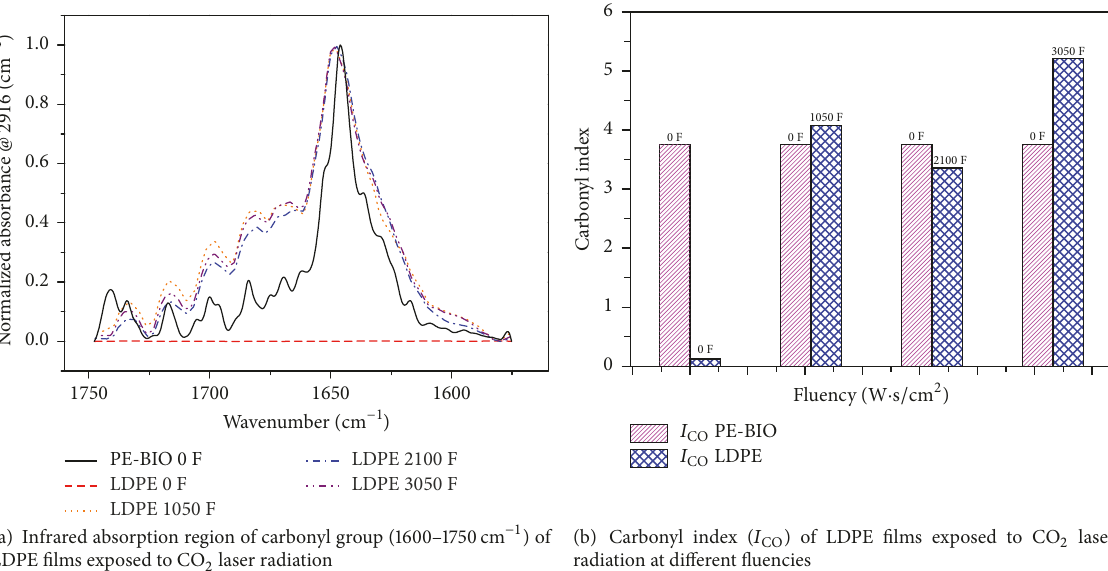
(a) Infrared absorption region of carbonyl group (1600–1750cm −1 ) of LDPE films exposed to CO 2 laser radiation